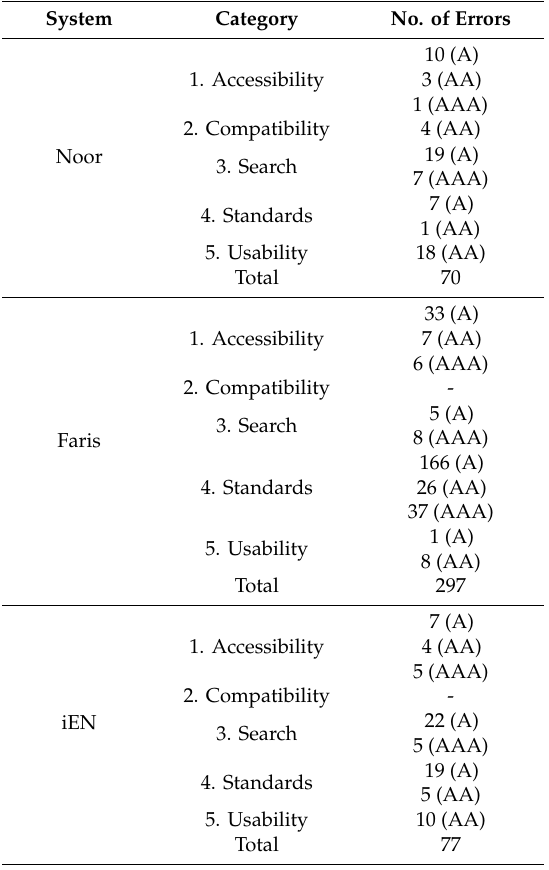
Table 9. SortSite tool